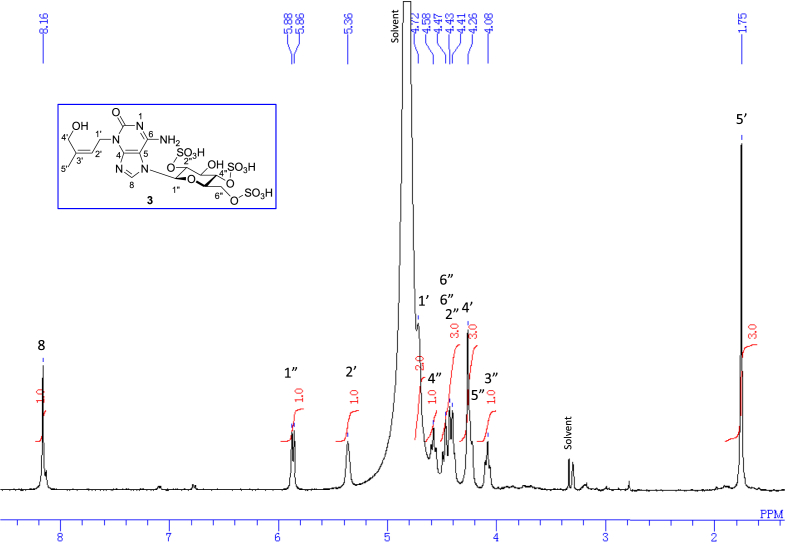
1H NMR (400 MHz, CD3OD–D2O, 1:9) of 3.